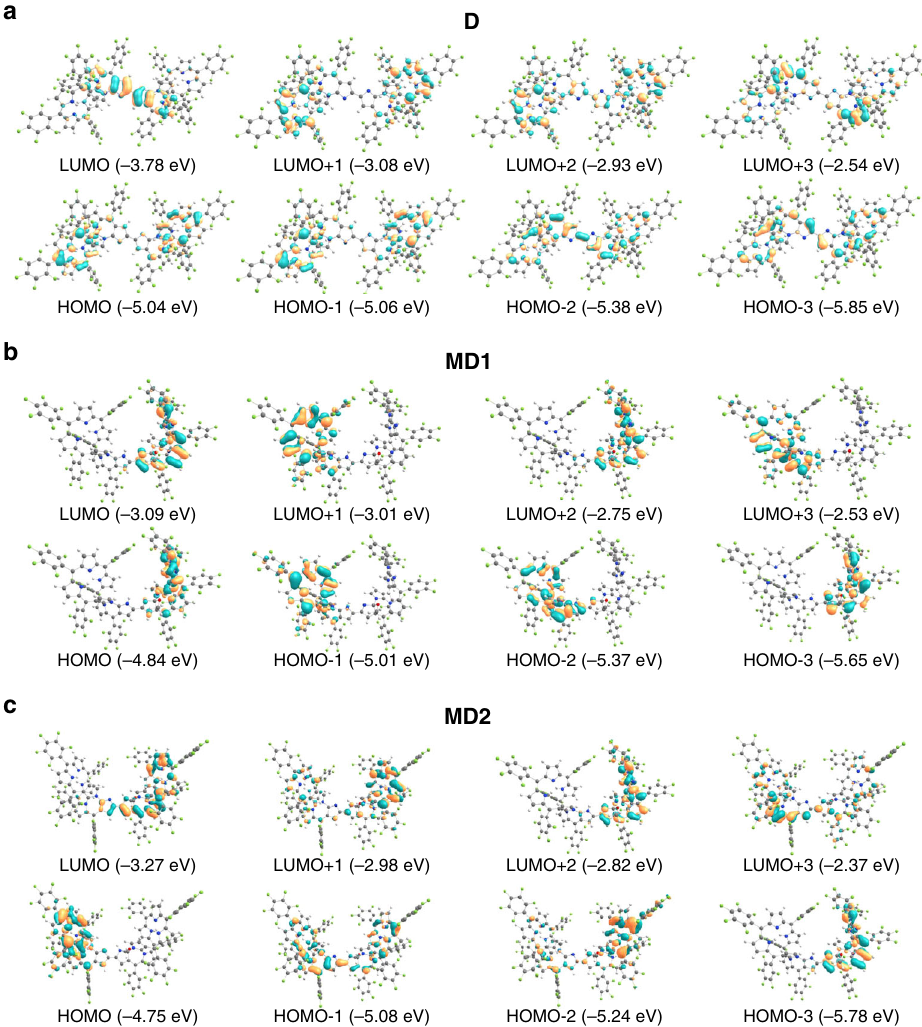
Fig. 7 Selected contour plots of the DFT-optimized structures and various orbitals for the compounds of this study. a – c stands for D , MD1 , and MD2 , respectively. The corresponding energy values are included in parentheses. The isosurface control value is 0.03 a.u. The occupied molecular orbitals are highlighted with blue and orange colors. C, N, O, H, and F atoms are denoted with balls of gray, red, white, and green colors,